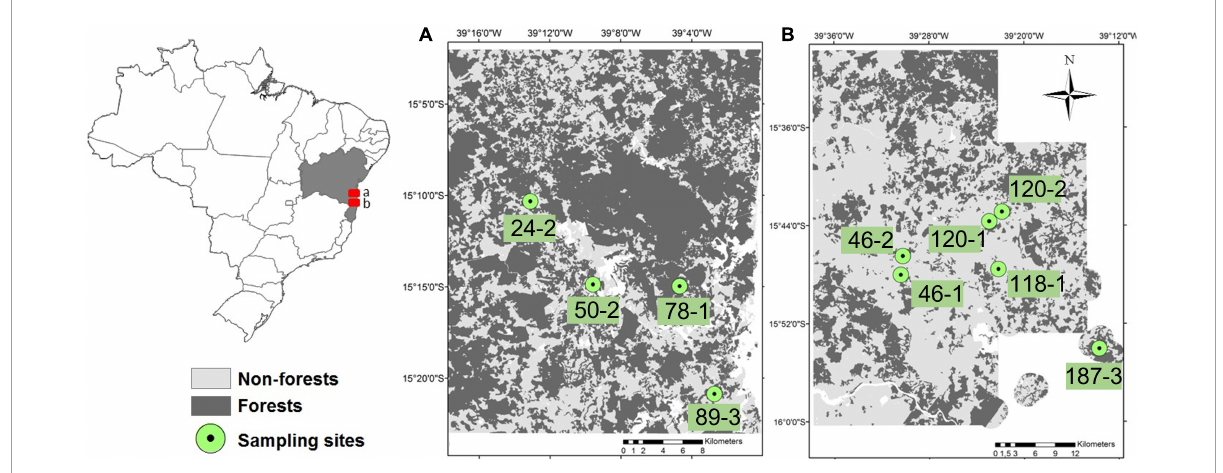
FIGURE1 Distribution of the 10 sampled forest fragments located in the Atlantic Forest of southern Bahia, including (A) Una region (Northern) and (B) Belmonte region